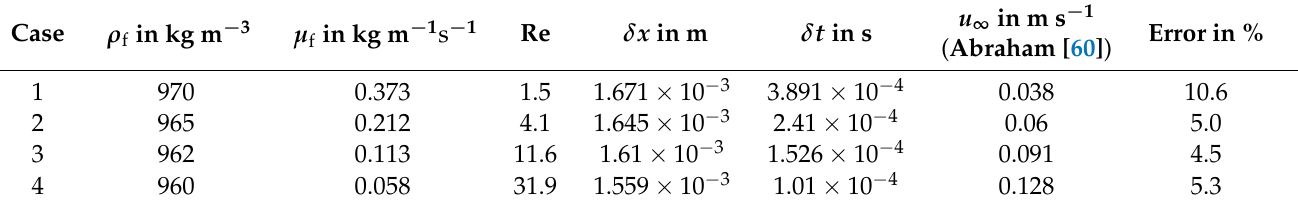
Table 1. Values of the setup of the four cases for a settling sphere investigated by ten Cate et al. [45] along with the deviation of their results to the maximum settling velocity u ∞ predicted with the drag correlation by Abraham [60].